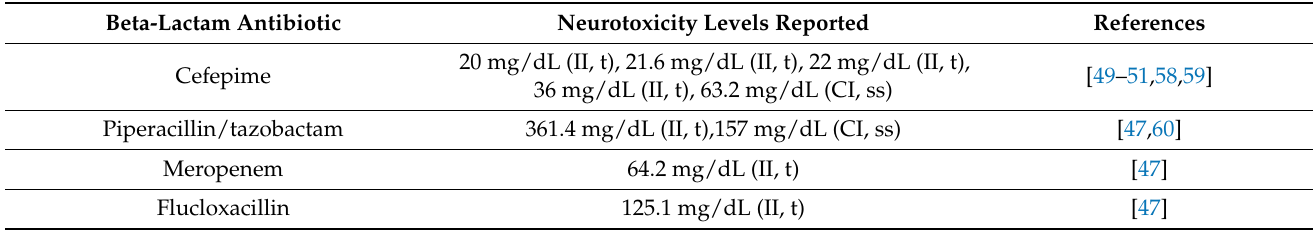
Table 1. Beta-lactam neurotoxicity